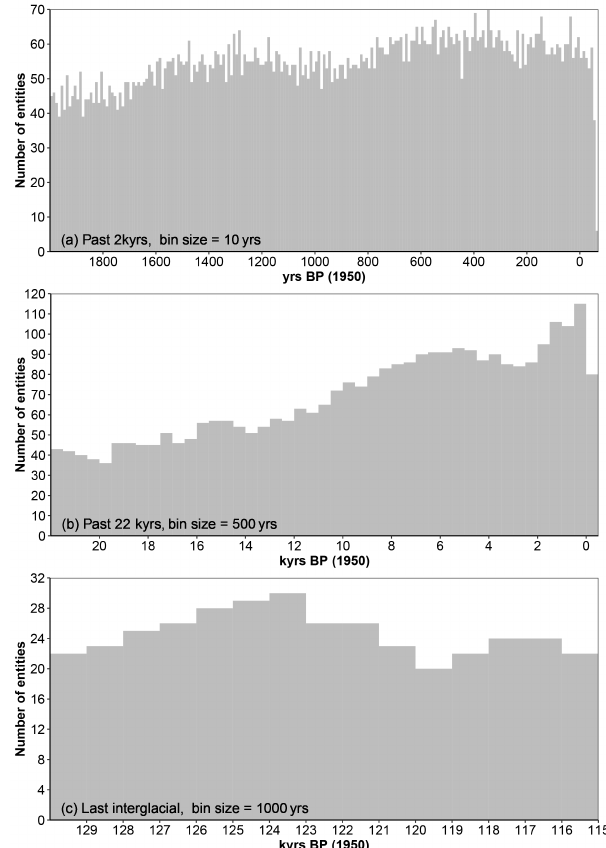
Figure 2. Plot showing the temporal coverage of individual entities in the database. Panel (a) shows records covering the past 2000 years (2kyrBP), (b) shows records covering the past 22000years (22kyrBP), and (c) shows records that cover the LIG